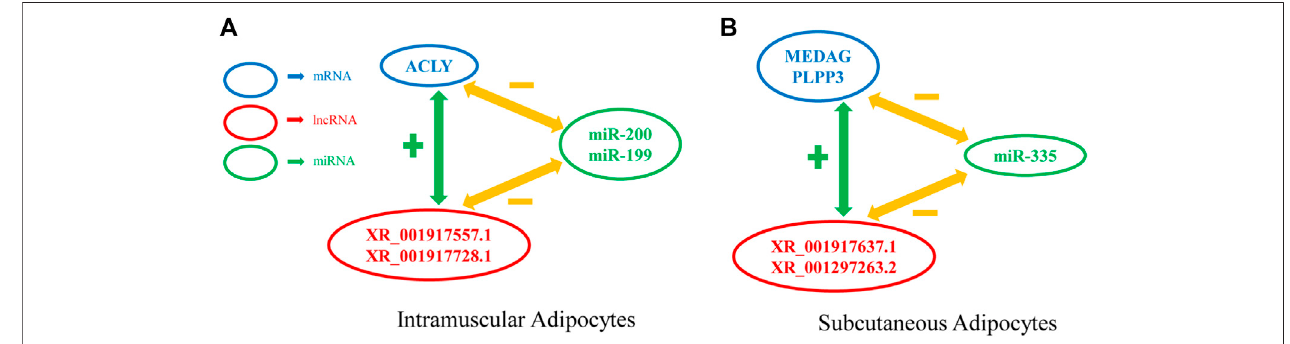
FIGURE 8 | Example of a pure sponge prediction module. (A) A pure sponge prediction module extracted from intramuscular adipocytes network. (B) A pure sponge prediction module extracted from intramuscular adipocytes